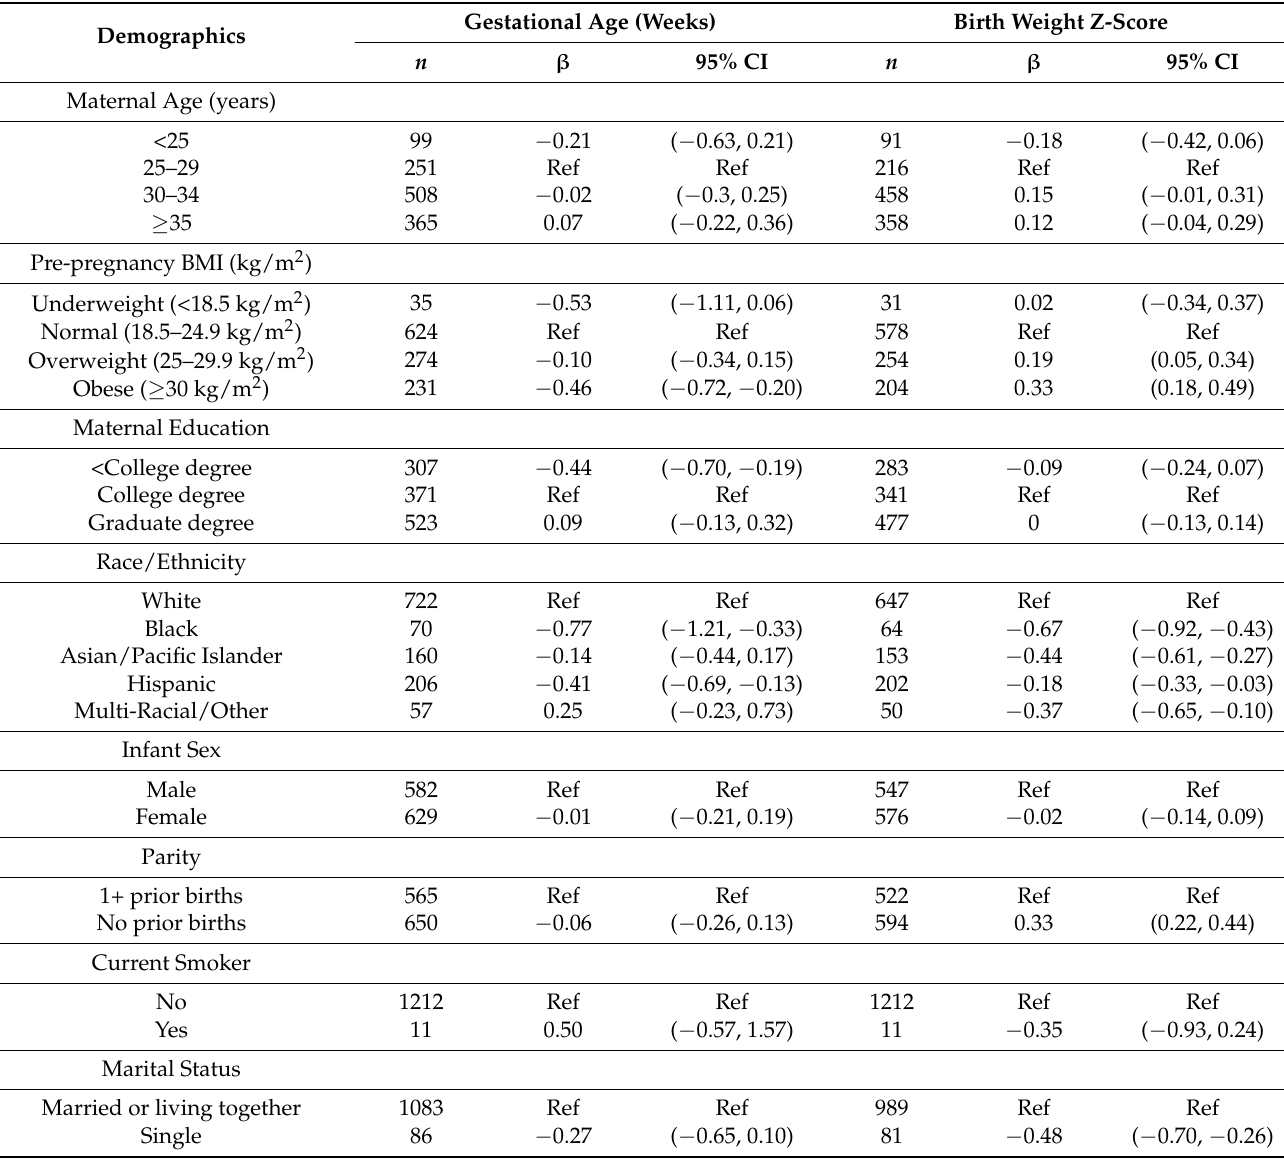
Table 3. Unadjusted associations between demographic characteristics and birth outcomes in total ECHO.CA.IL